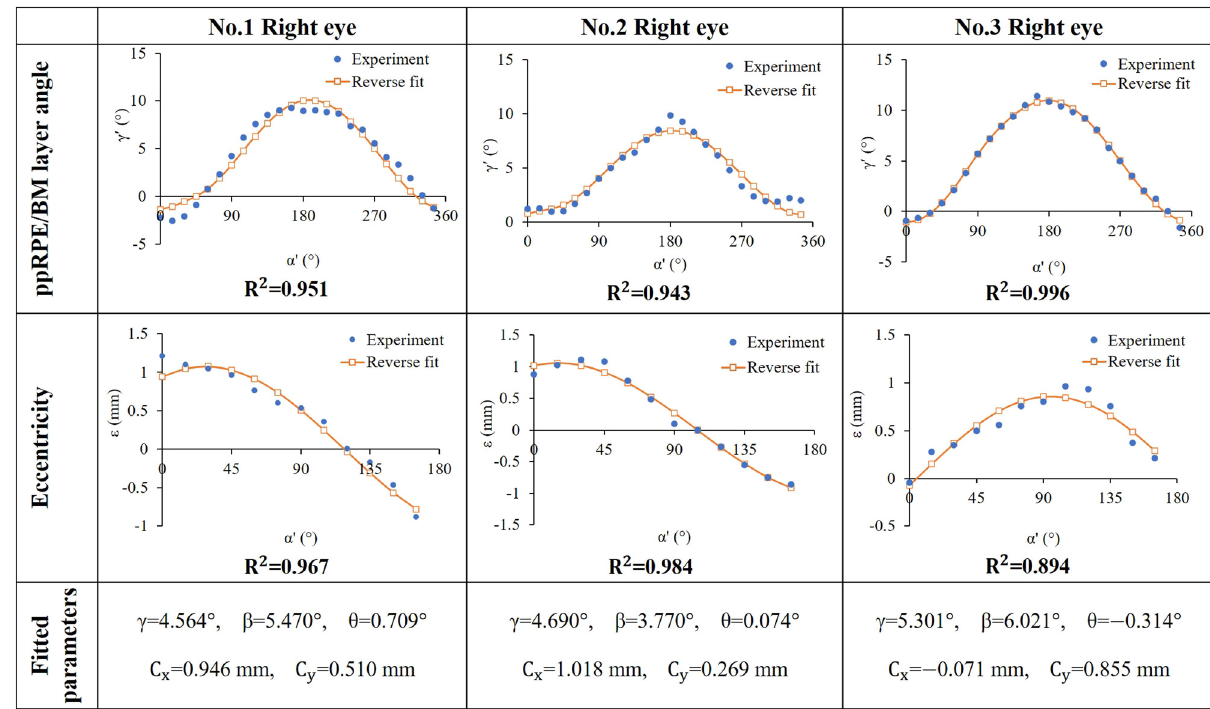
Figure 7: Comparison between the experimental measurements and model fi tting results of with respect to γ ′ ( fi rst row ) and ε ( second row ) of three right eyes. The fi tted parameters were listed in the third row.